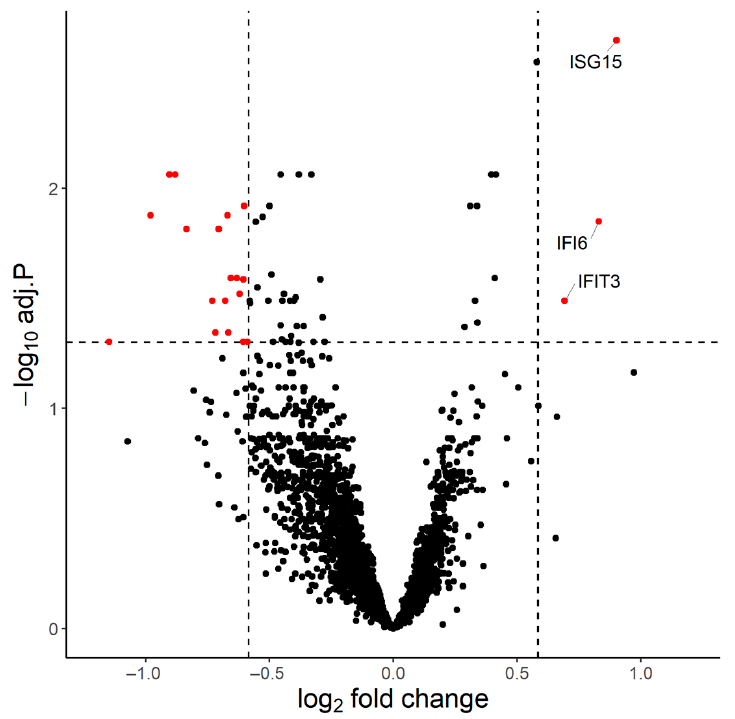
Figure 2. Innate antiviral immune response induced by dual mRNA BNT162b2 immunization. Volcano plot of the differentially expressed genes on D24 compared to D21 (p.adj < 0.05 and Fold Change > 1.5 for the upregulated genes, p.adj < 0.05 and FC < 1.5 for the downregulated genes). Three genes were upregulated (IFI6, IFIT3, ISG15), all involved in antiviral immunity and type I interferon